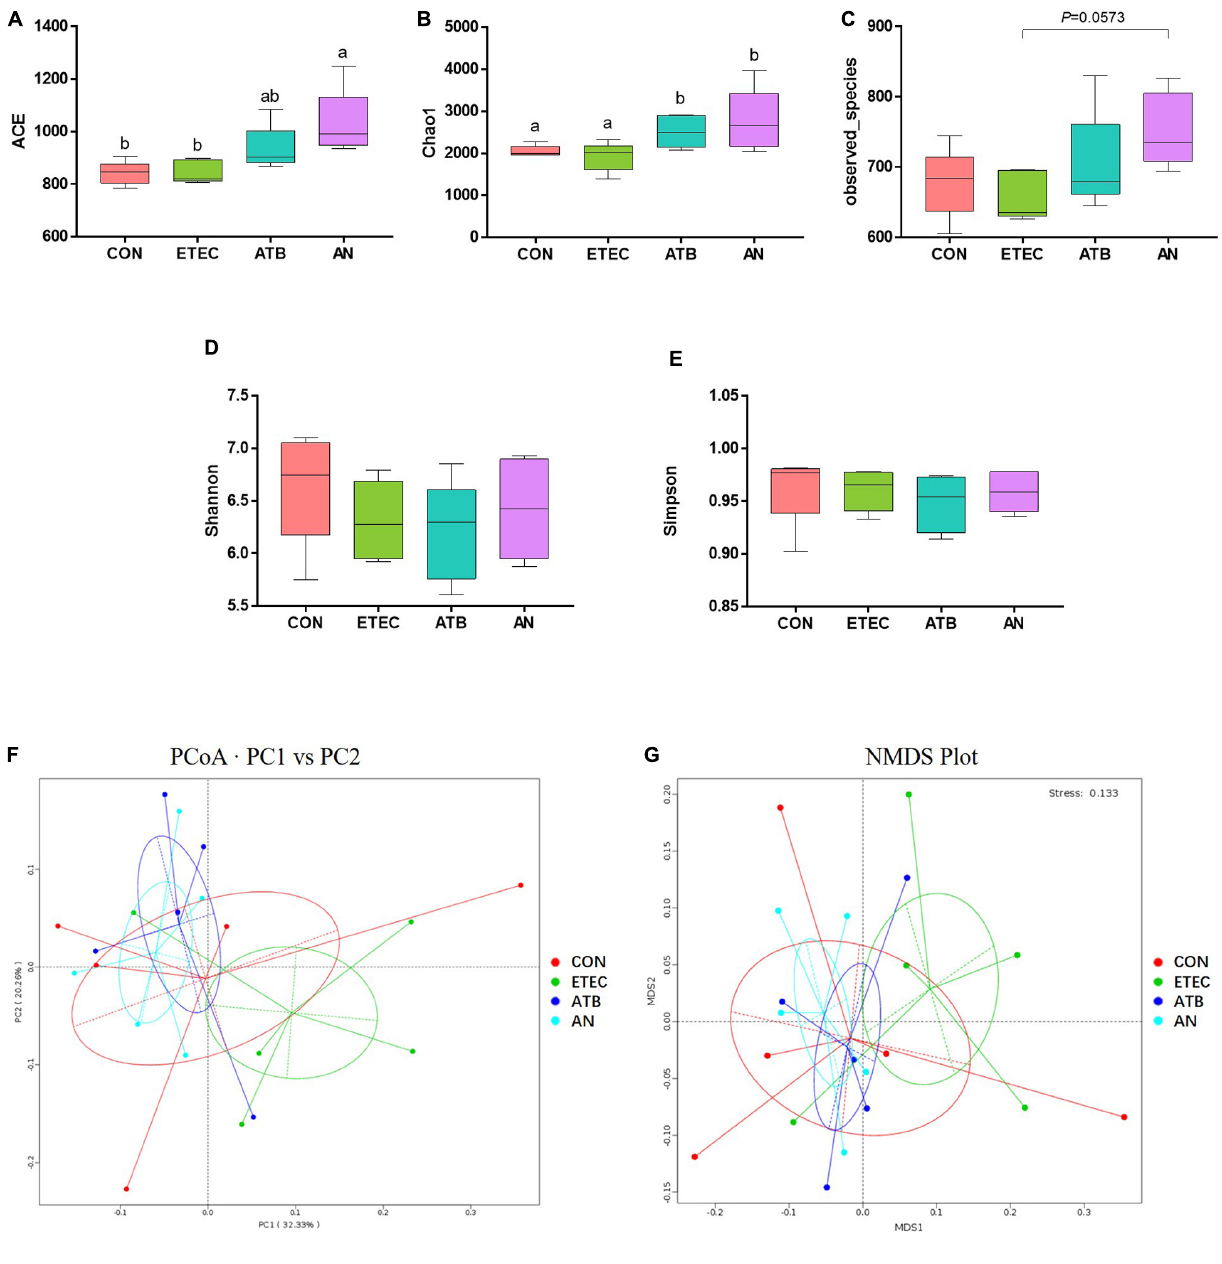
FIGURE 4 | Effects of anethole on alpha diversity and beta diversity of fecal microbiota of piglets challenged with enterotoxigenic Escherichia coli K88 ( n = 5). (A–E) Alpha Diversity index: ACE, Chao1, Observed_species, Shannon, Simpson. (F) Principal Coordinates Analysis based weighted Unifrac. (G) NMDS Plot Analysis based weighted